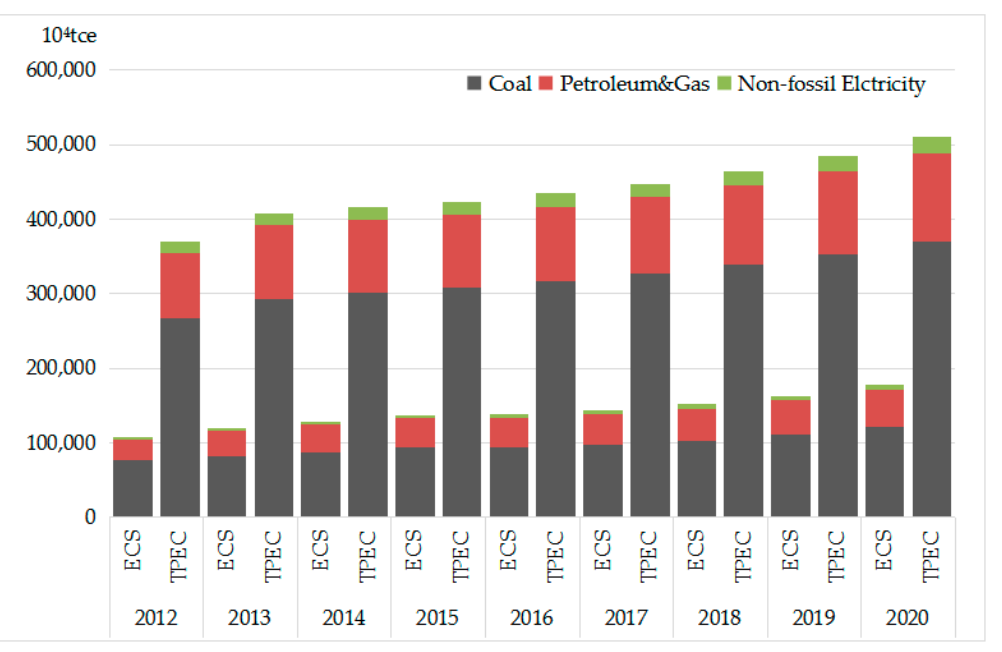
Figure 2. Forecast results of the total primary energy consumption (TPEC) and energy embodied in construction services (EECS) of China.